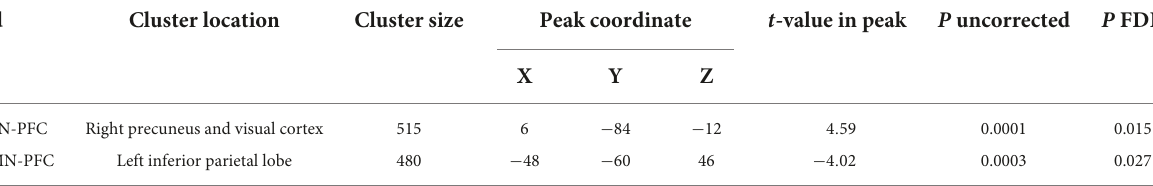
TABLE 2 Significant time by intervention interaction clusters in terms of PPI connectivity obtained from the seed-to-whole brain gPPI analysis. Seed Cluster location Cluster size Peak coordinate t -value in peak P uncorrected P FDR X Y Z R-ECN-PFC Right precuneus and visual cortex 515 6 − 84 − 12 4 . 59 0.0001 0.015 R-DMN-PFC Left inferior parietal lobe 480 − 48 − 60 46 − 4 . 02 0.0003